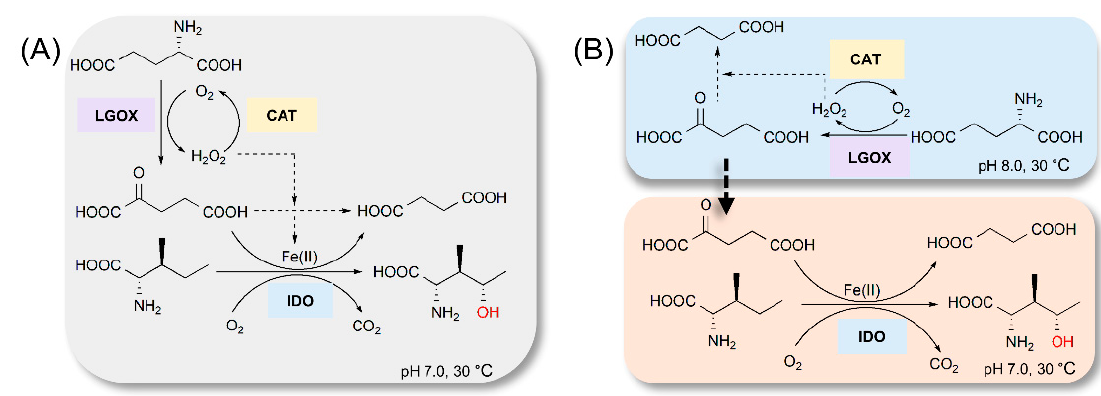
Figure 3. Enzymatic cascade production of 4-HIL. ( A ) Scheme of one-pot production of 4-HIL. ( B ) Scheme of multistep reaction to produce 4-HIL.